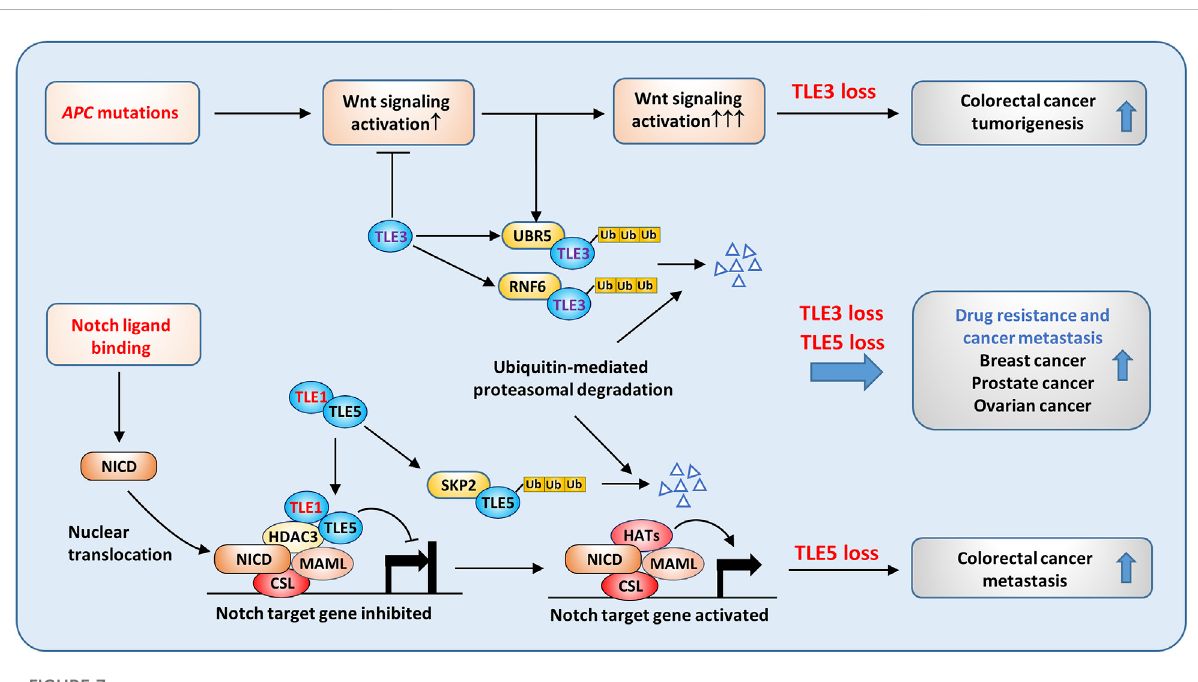
FIGURE 7 Tumor suppressive roles of TLEs in solid tumors. Aberrant Wnt signaling activation caused by APC mutation is common in colorectal cancer. TLE3 suppresses Wnt activation in normal epithelial cells, but in cancer cells, ubiquitin ligases, such as UBR5 and RNF6, are upregulated and are responsible for TLE3 ubiquitination and degradation. As a result, loss of TLE3 promotes colorectal tumorigenesis by enhancing Wnt activation. TLE5 suppresses colorectal cancer metastasis byinhibitingNotch signaling. SKP2-mediated TLE5 ubiquitinationand degradationlead